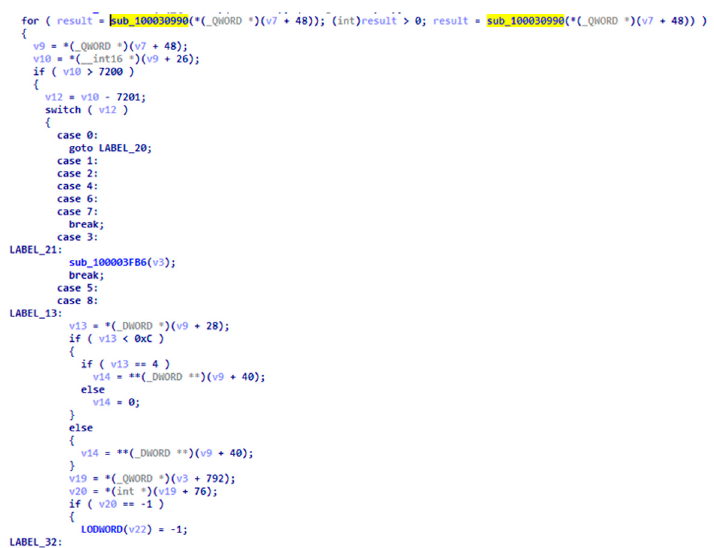
Figure A4. Data processing after calling recv().